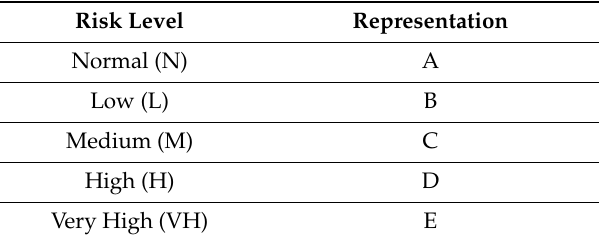
Table 1. Representation of output risk level classifications.